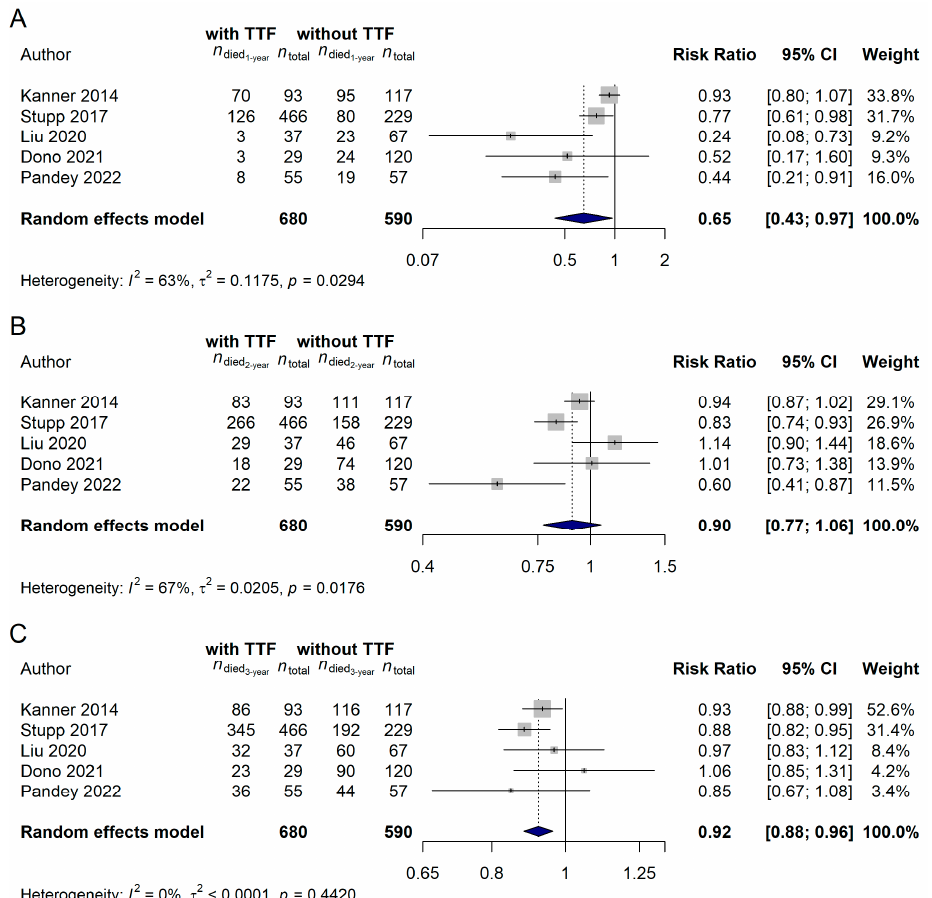
Figure 8. Glioblastoma patients treated with Tumor Treating Fields (TTF) had significantly better ( A ) 1-year ( p = 0.0335) and ( C ) 3-year ( p = 0.0003) survival rates, while no difference in the ( B ) 2-year survival rates could be justified ( p = 0.2062) compared with those who did not receive TTF during their treatment [15,21,57,69,70].